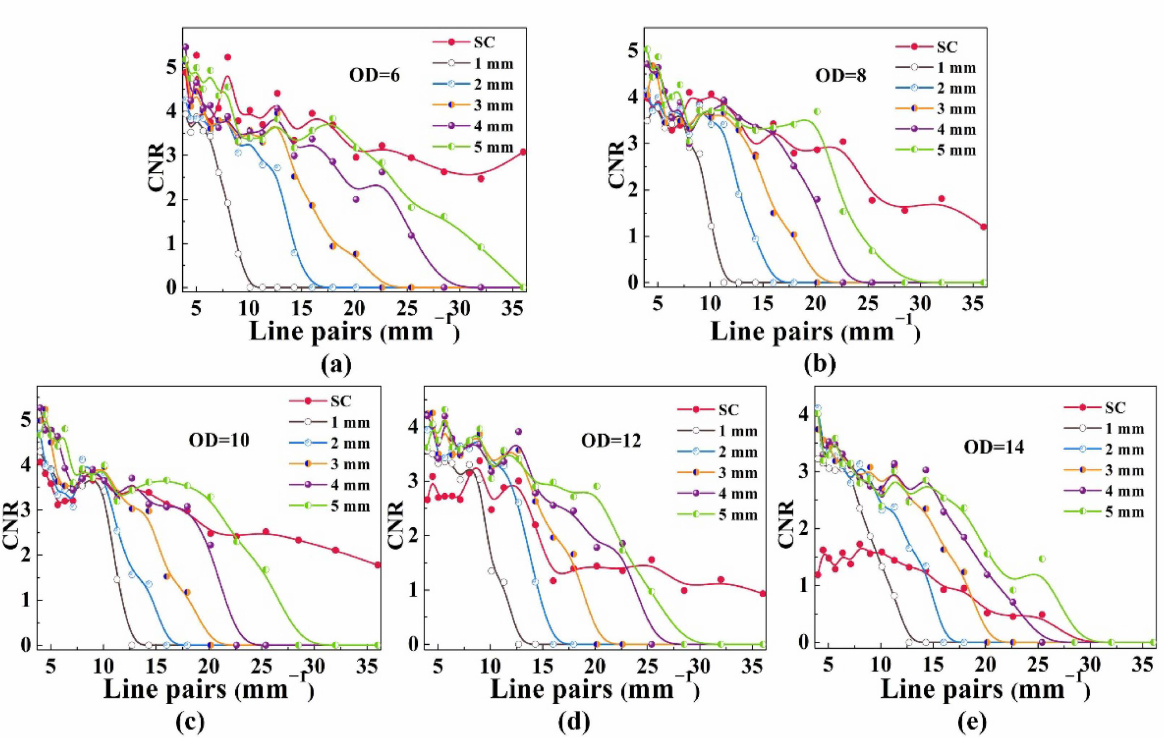
Figure 5. CNR curves for imaging using SC illumination with and without Fourier spatial gate at different ODs: ( a ) OD = 6, ( b ) OD = 8, ( c ) OD = 10, ( d ) OD = 12, and ( e ) OD =